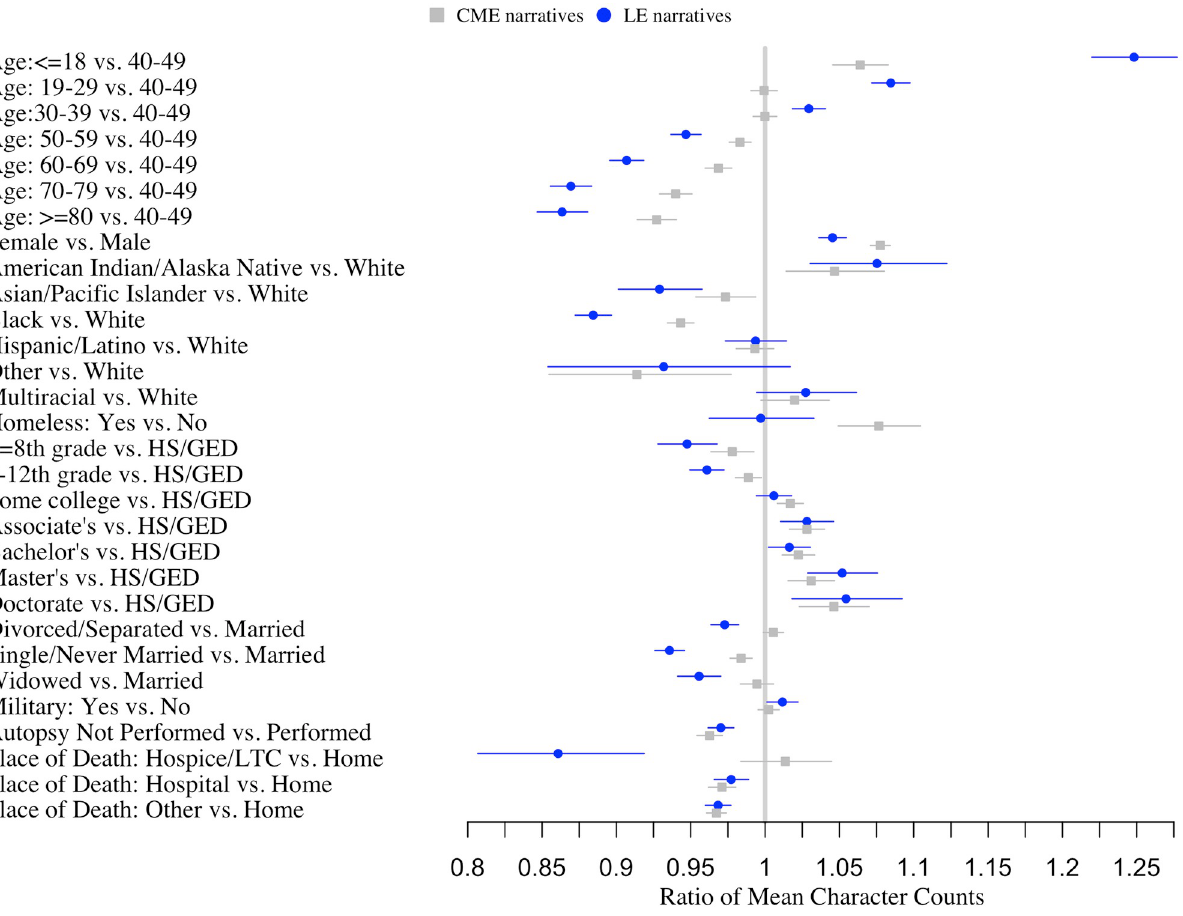
Fig 3. Forest plot of relative ratios (95% confidence intervals) of the mean length of C/ME and LE narrative texts associated with decedent characteristics, NVDRS 2003–2017. Estimates are adjusted for all variables show in the figure as well as year, location of death, and autopsy status and account for clustering within site using GEE with robust standard